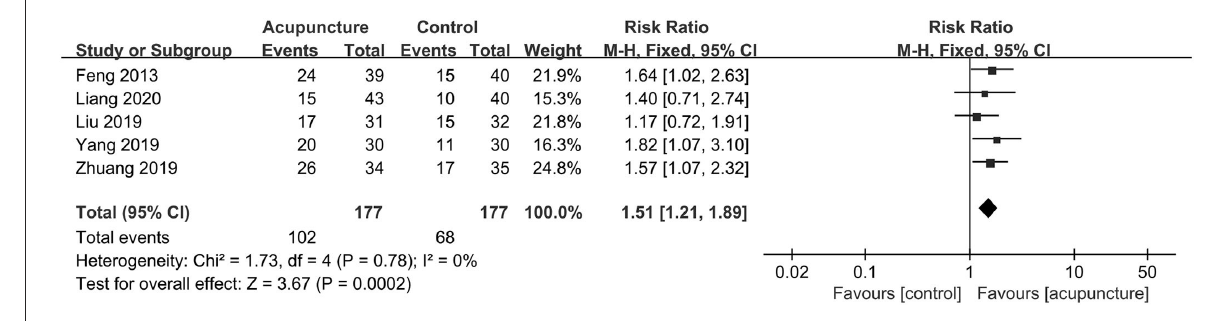
FIGURE4 Forest plot of biochemical pregnancy rate.